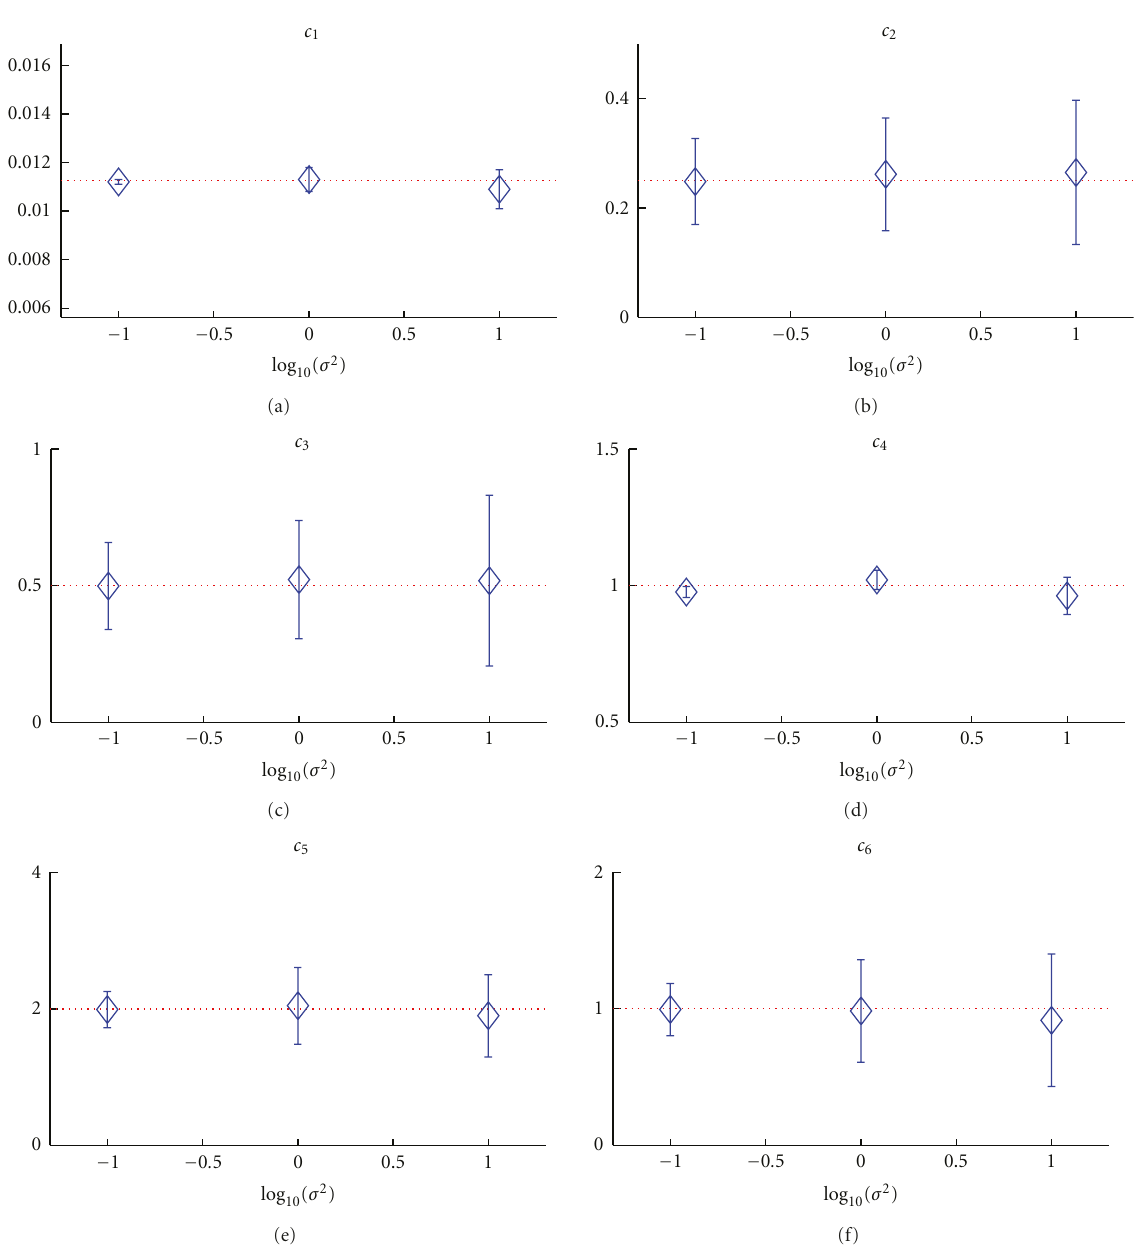
Figure 3: The mean and standard error of the particle filter estimator for the inference of reaction rates in a viral infection network, shown as a function of the variance of the observation noise (the number of particles used is N s = 10 4 ; performance is averaged over 150 simulation